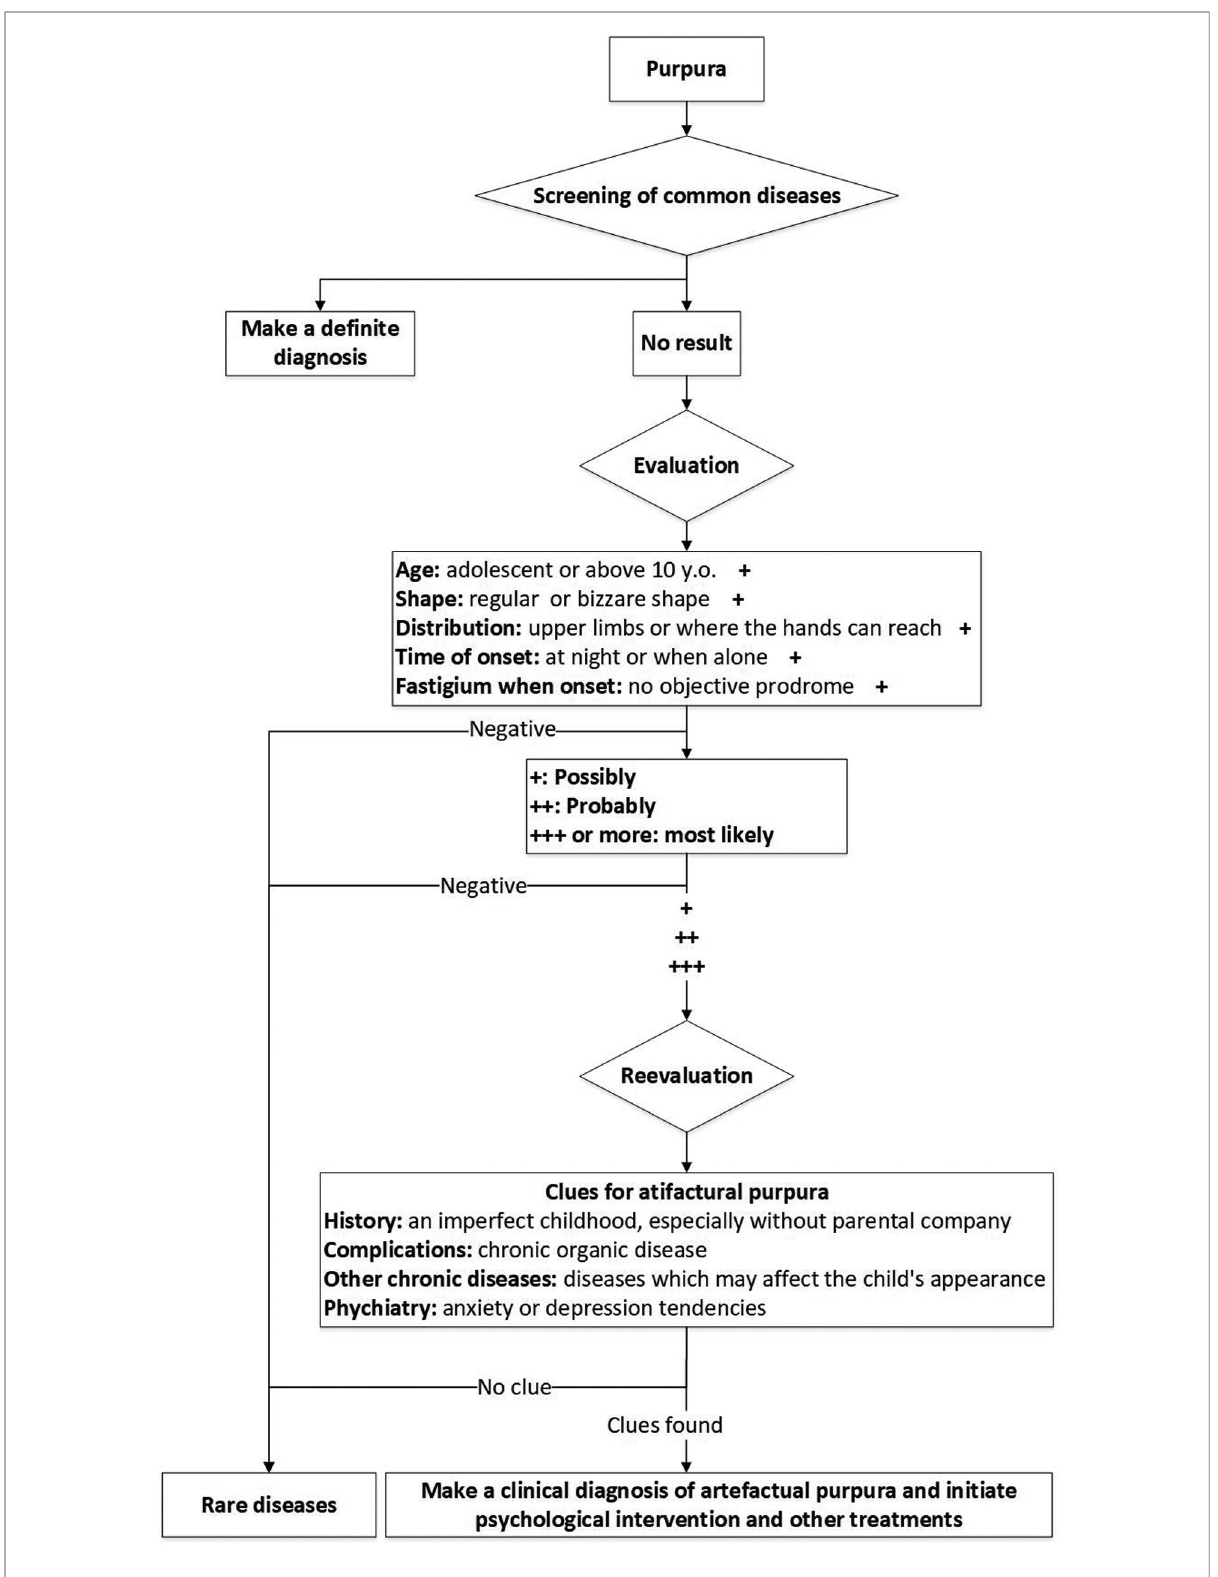
FIGURE 3 Rapid diagnostic process for artefactual